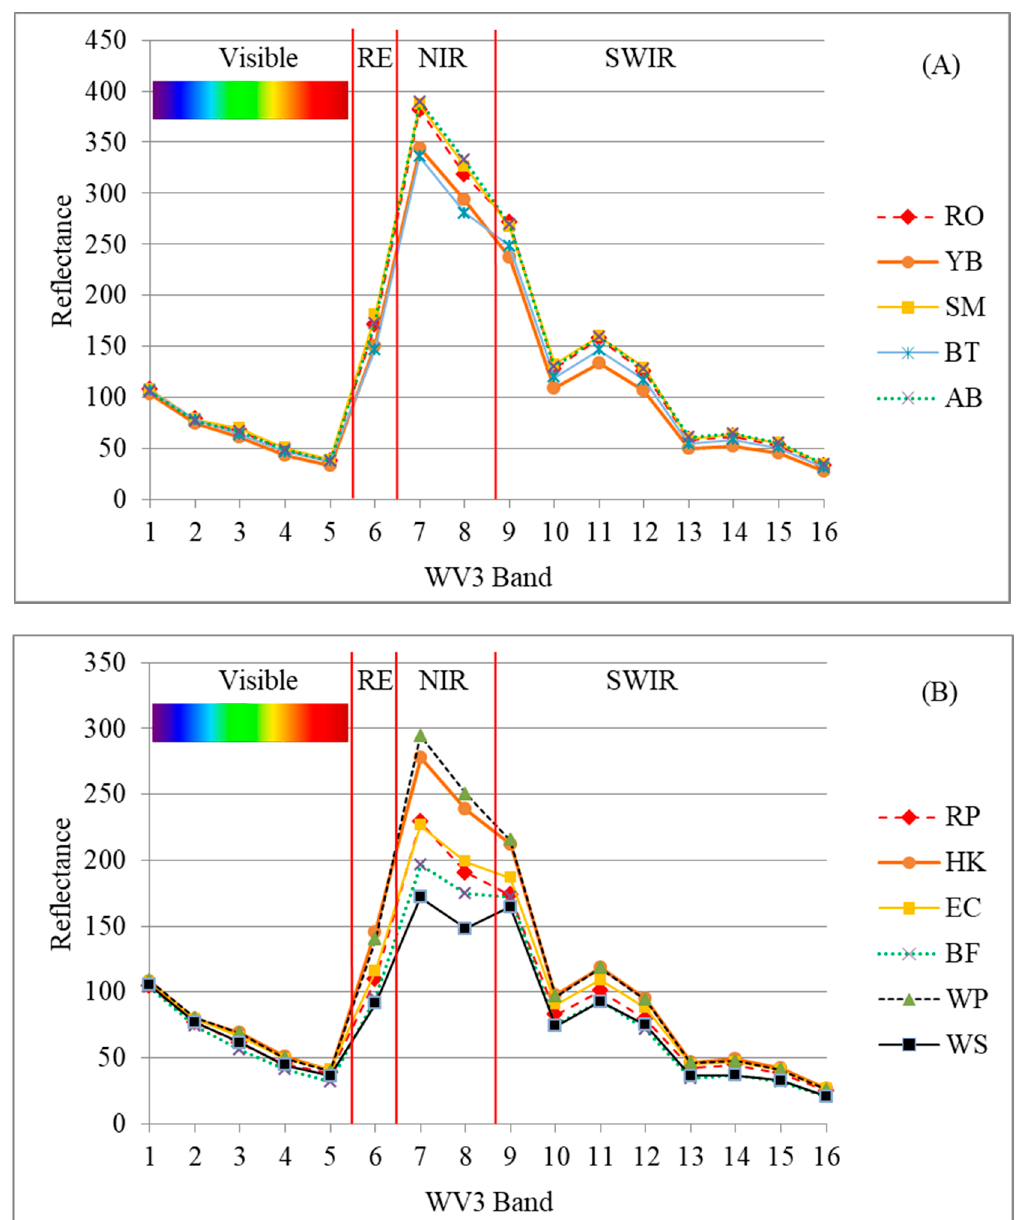
Figure 5. Spectral signatures for selected broadleaf ( A ) and conifer ( B ) species with 16-bands WorldView-3 (WV3). The points are the mean spectral values of the training samples. The spectral signatures are separated into four parts: visible, Red-edge (RE), Near-infrared (NIR) and Short-Wave Infrared (SWIR). The species’ abbreviations and the number of training samples used to calculate the mean are described in Table 2.